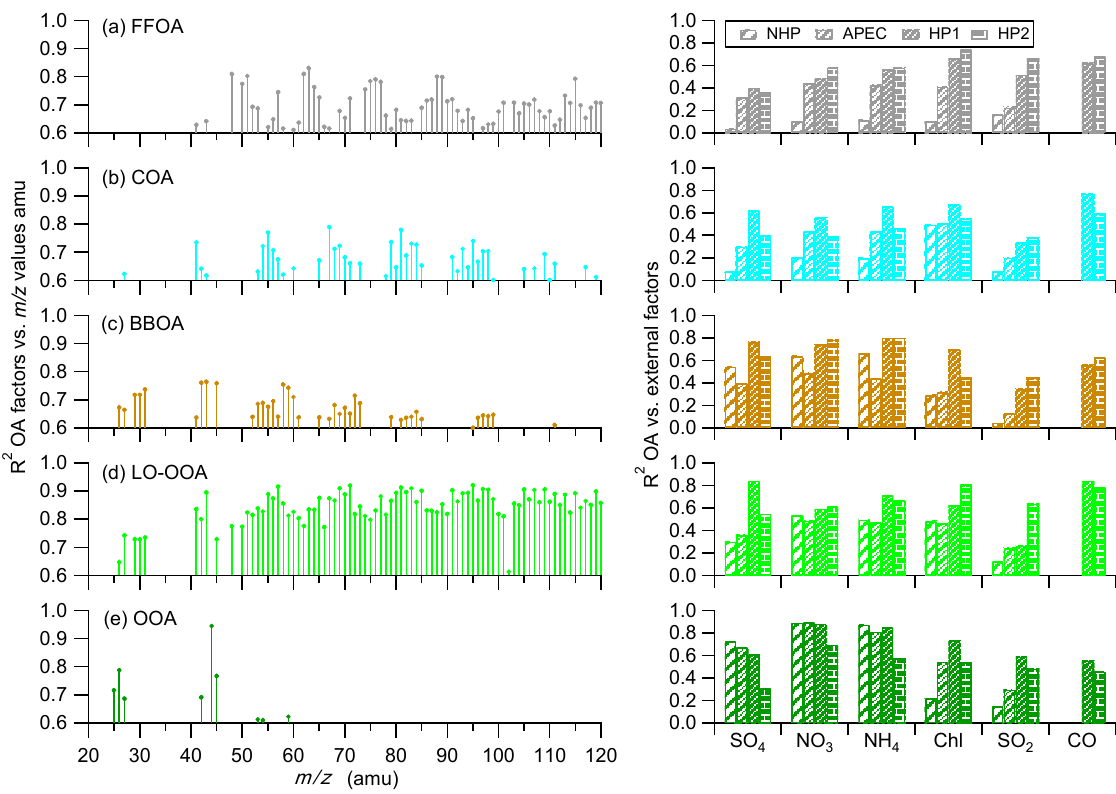
Figure 6. Correlations among the five OA factors, m/z values (left panel), and external tracer species (right panel) during the four different periods, i.e., NHP, APEC, HP1, and